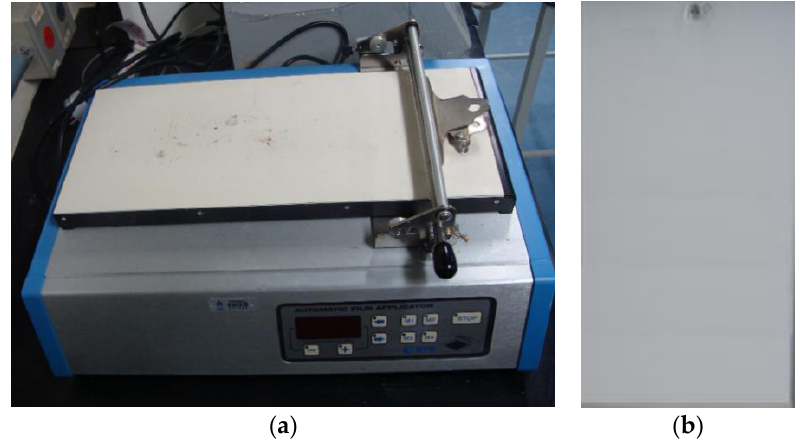
Figure 1. ( a ) automatic film applicator BYK-Gardner, with dimensions of 56.6 cm × 20.3 cm × 31 cm, and ( b ) AISI 1010 steel sample, with dimensions of 10 cm × 5 cm.